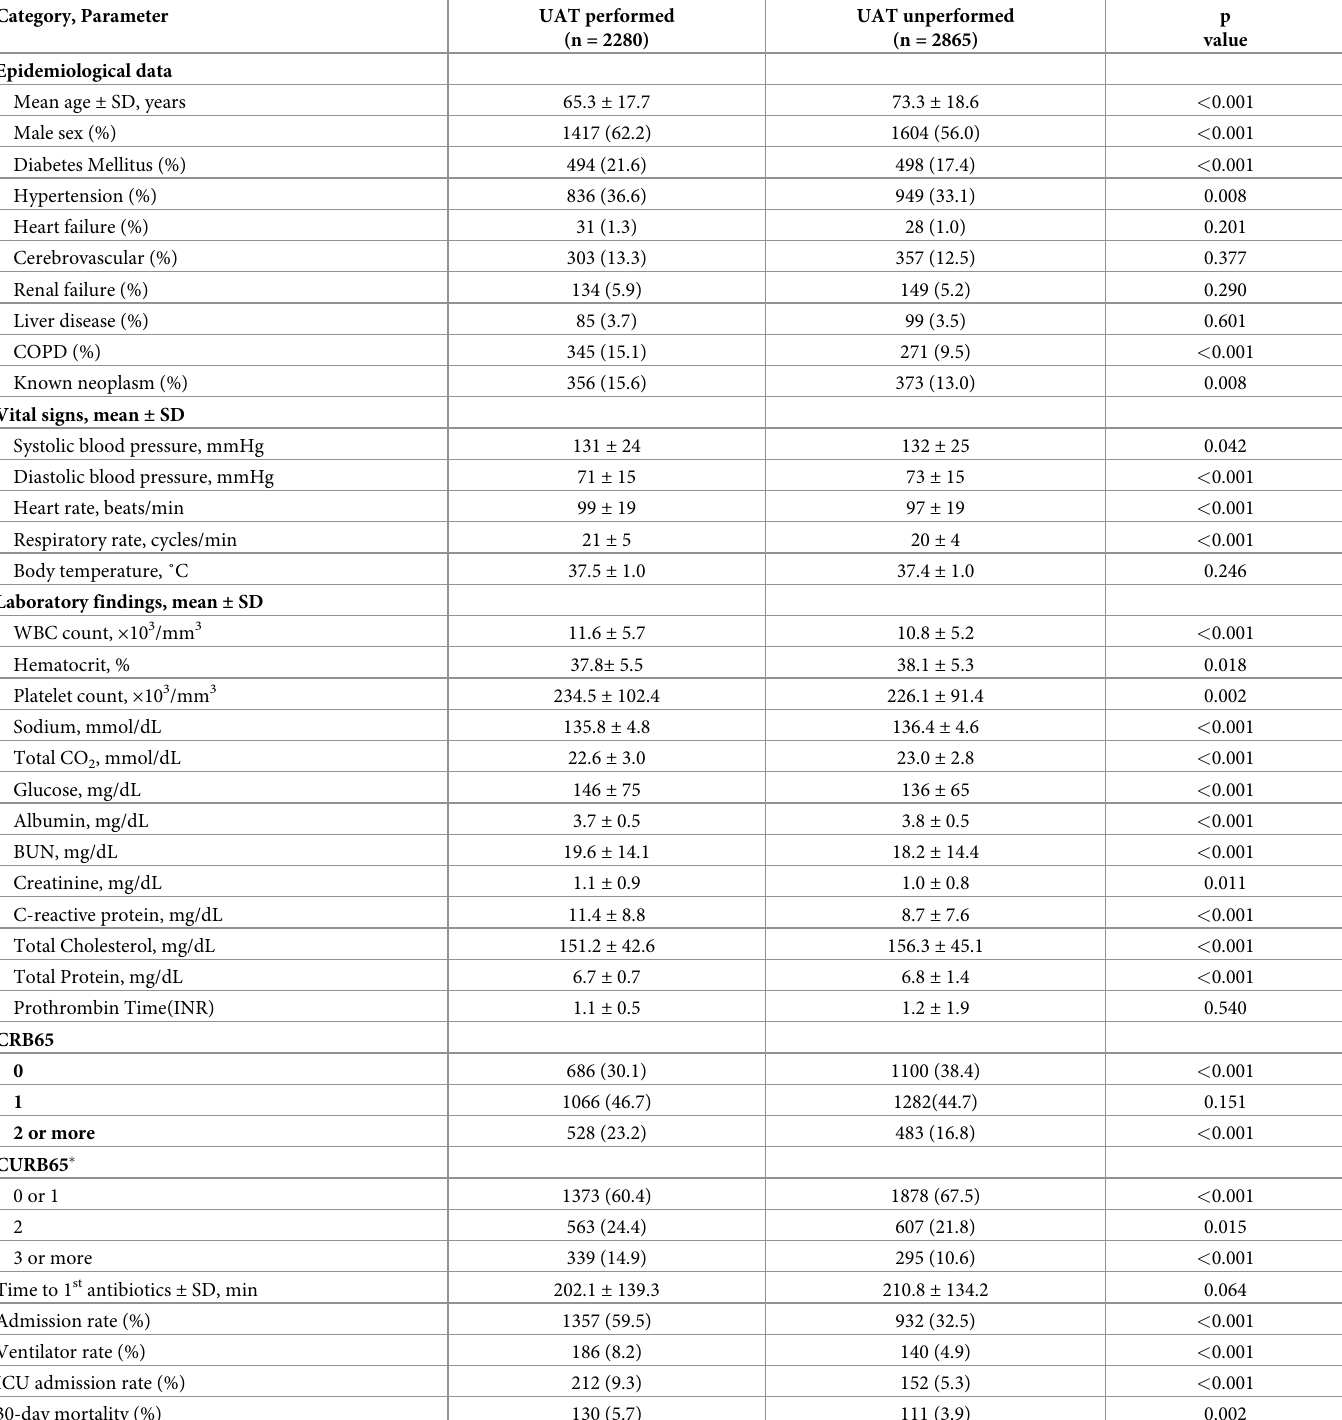
Table 1. Baseline characteristics of patients with or without